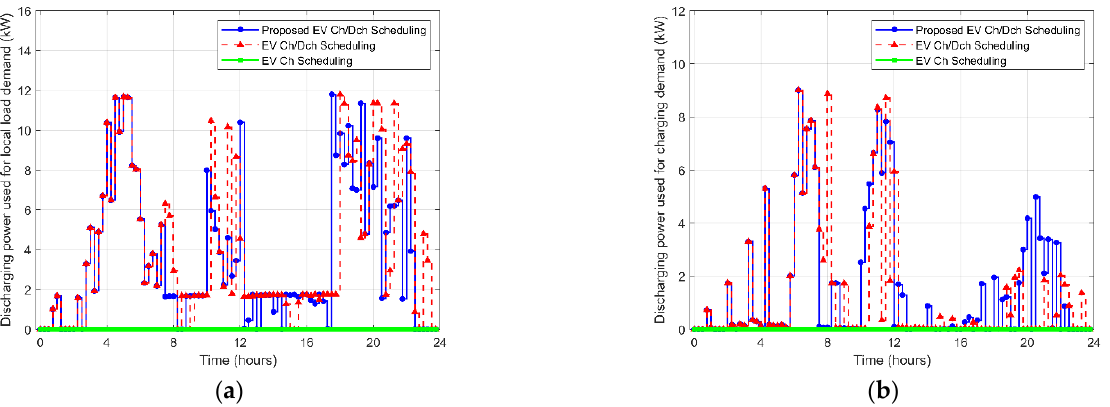
Figure 12. ( a ) The discharging power of parked EVs used for local load demand; ( b ) the discharging power of EVs used for charging demand of EVs.